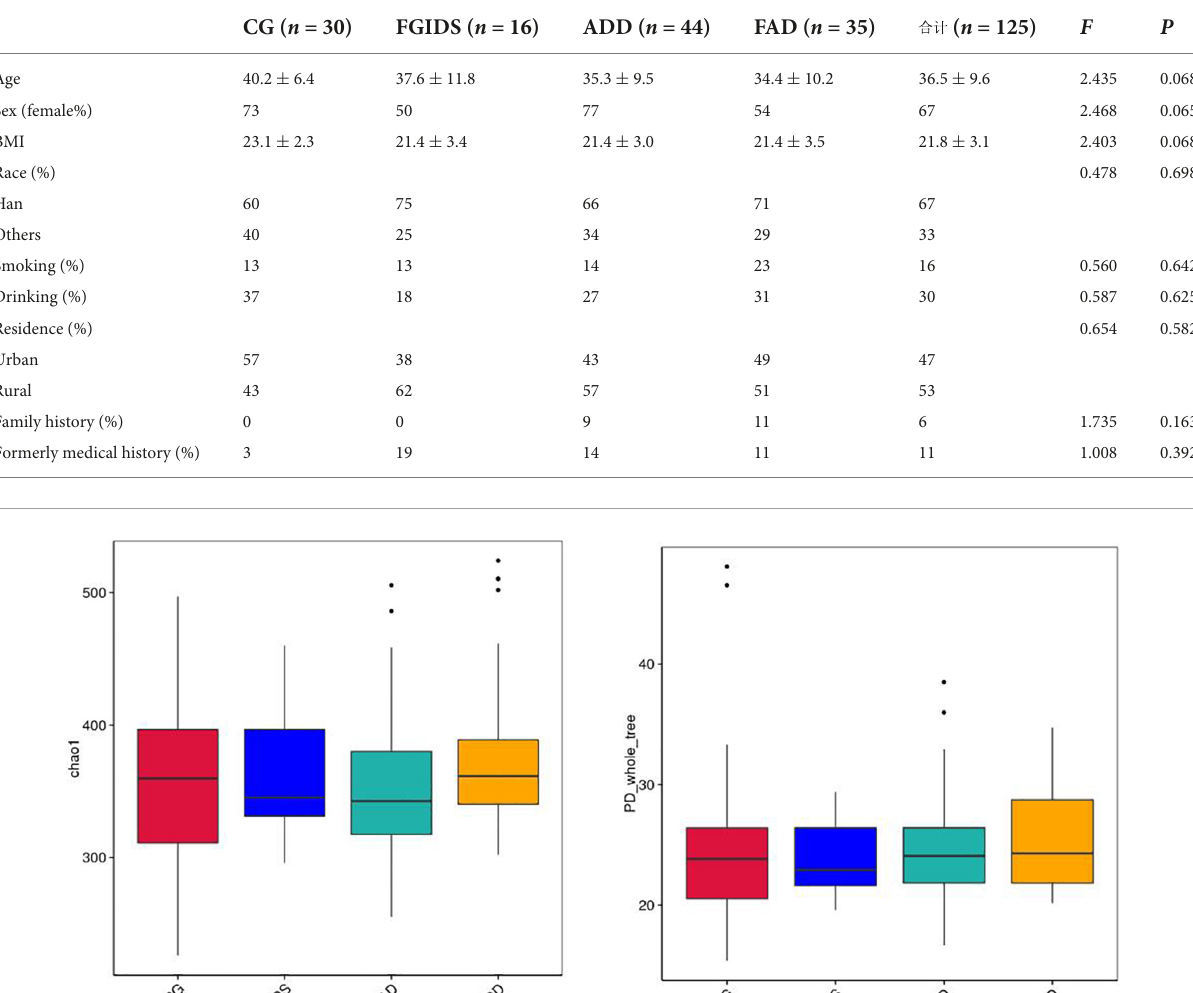
TABLE 1 Clinical parameters and demographic information of subjects.